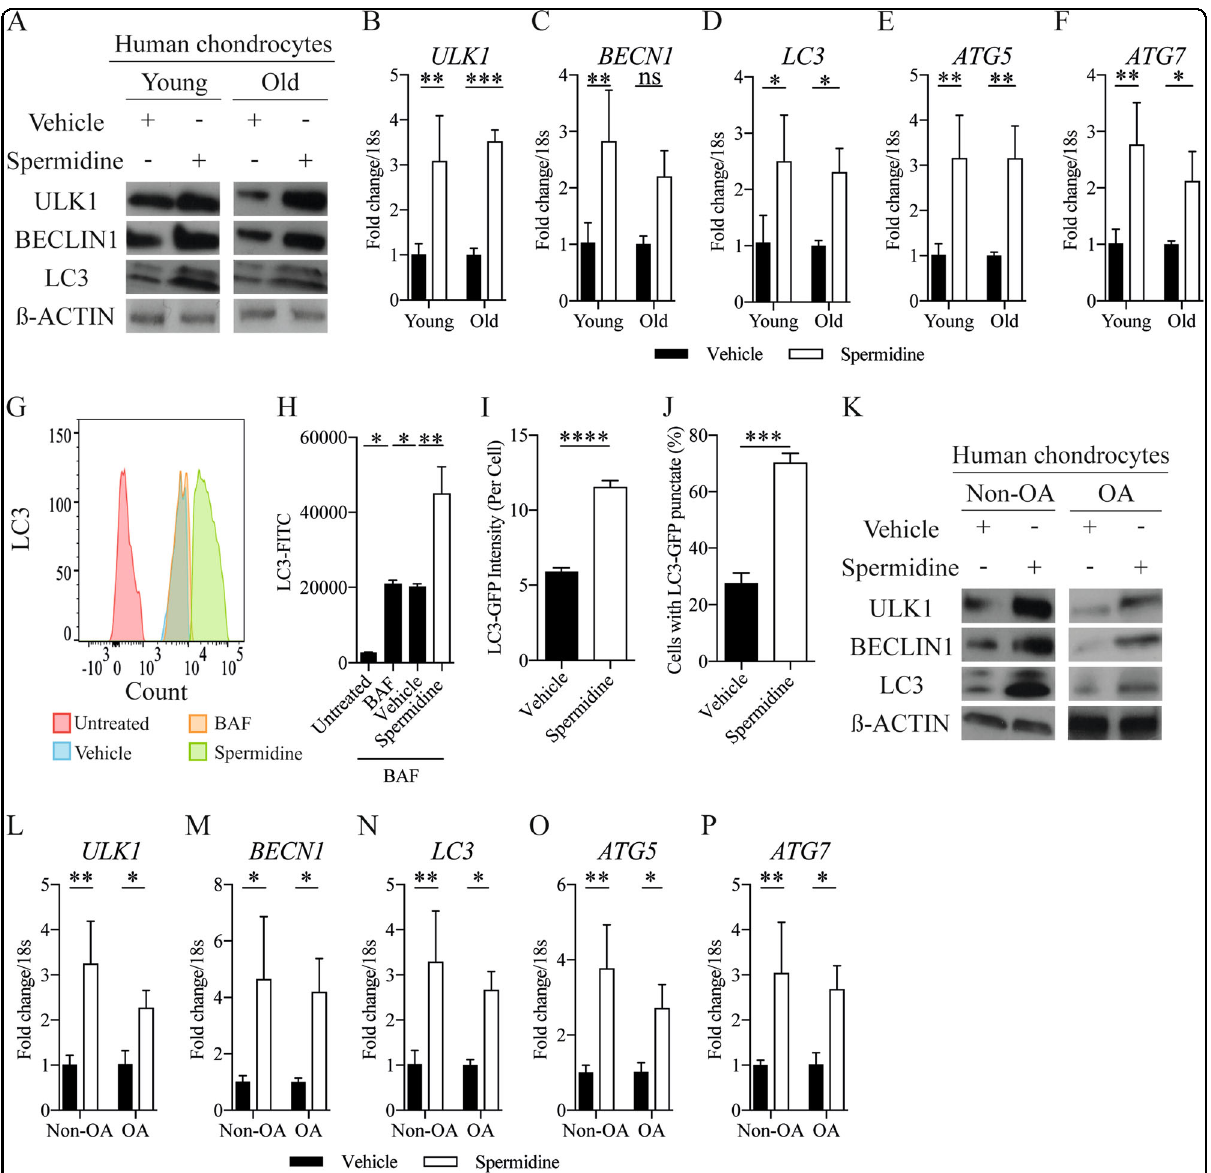
Fig. 2 Spermidine activates chondrocyte autophagy. ( a ) Autophagy protein expression and ( b – f ) autophagy gene expression (RT-qPCR) in isolated chondrocytes from young (21 – 37 years) and old (62 – 68 years) human knee joints treated with DMSO control or spermidine (100 nM) ( n = 3). g Histogram and ( h ) quanti fi cation of MFI of LC3-II in HTB-94 cells either untreated or treated with BAF (10 nM), alongside DMSO (vehicle control) or spermidine (100 nM), for 2 h ( n = 3). i Total LC3-GFP intensity and ( j ) quanti fi cation of percentage of chondrocytes with LC3 positive punctate